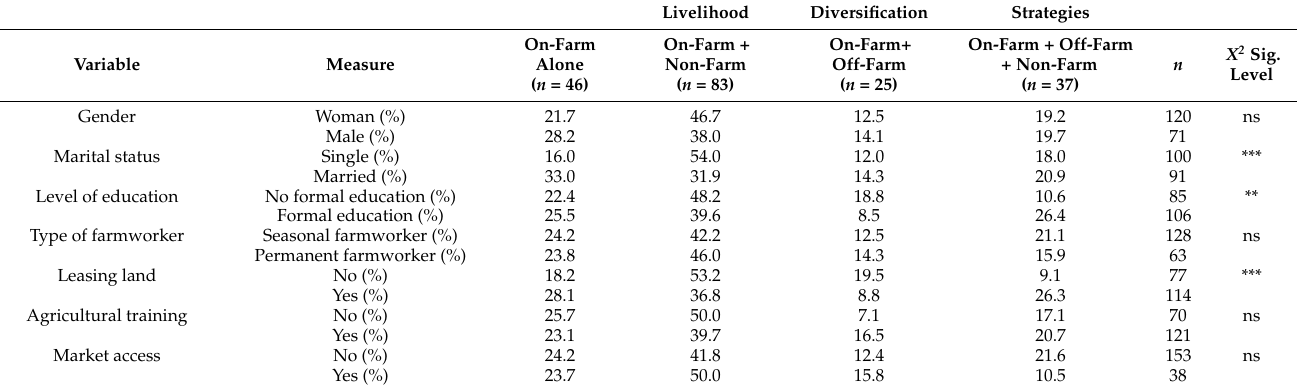
Table 6. Association between livelihood-diversification strategies and socioeconomic